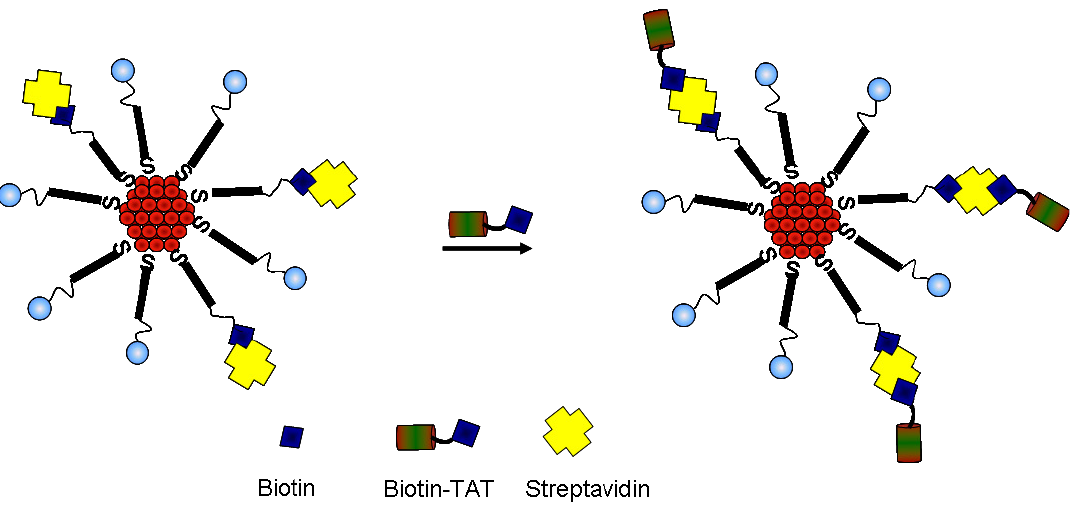
Scheme 3. A schematic representation of the introduction of Trans-Activator of Transcription (TAT) peptide onto the streptavidin gold